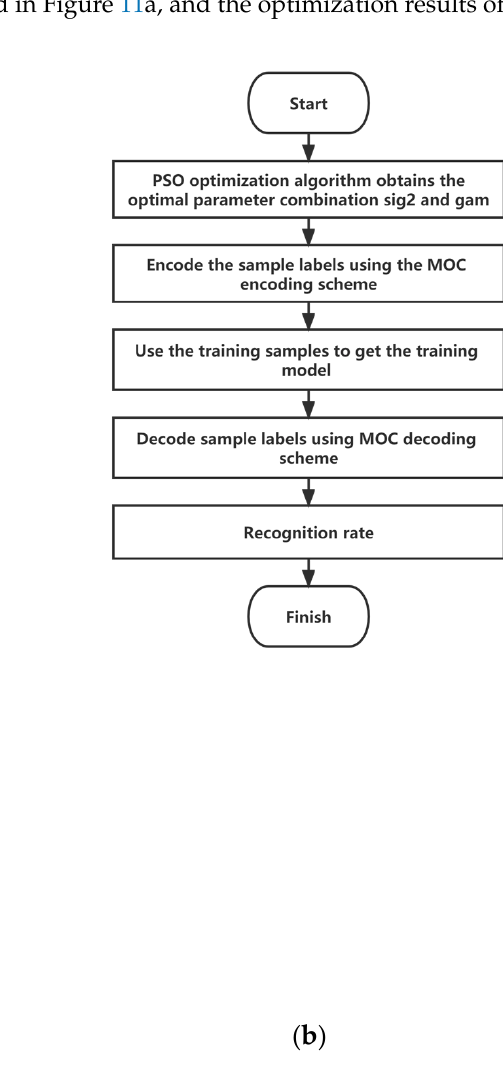
Figure 11. ( a ) Using particle swarm optimization (PSO) to optimize the regularization parameter gam and kernel parameter sig of LSSVM to find the optimal combination of parameters; ( b ) PSO-LSSVM flow chart. Table 6. The result of the gam and sig2 parameters.